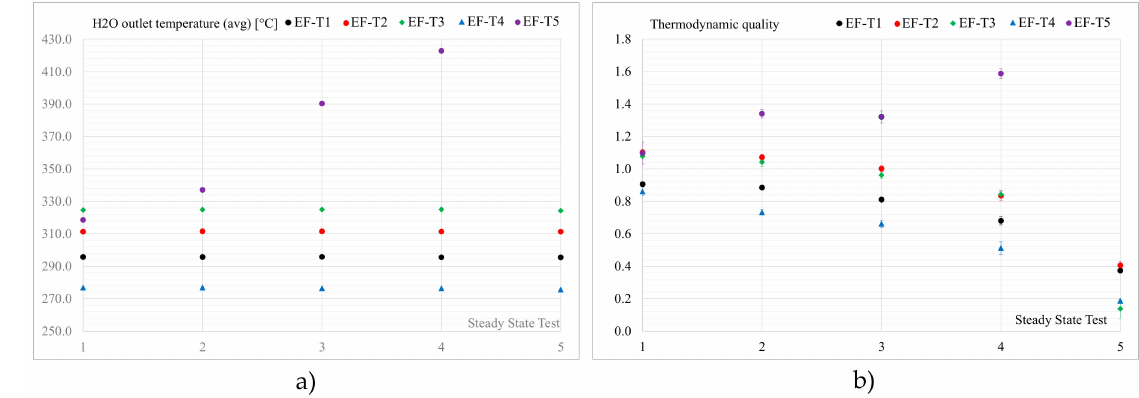
Figure 10. Experimental data at SGBT outlet for all the tests: ( a ) average water temperature and ( b ) thermodynamic